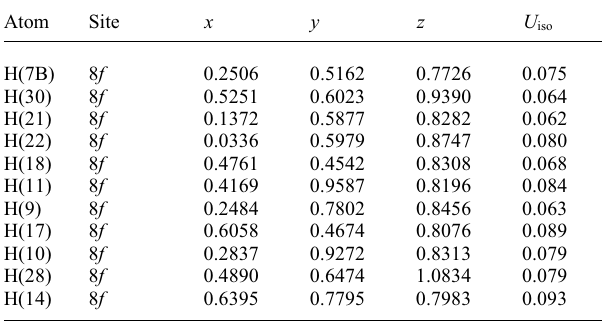
Table 2. Atomic coordinates and displacement parameters (in Å 2 )